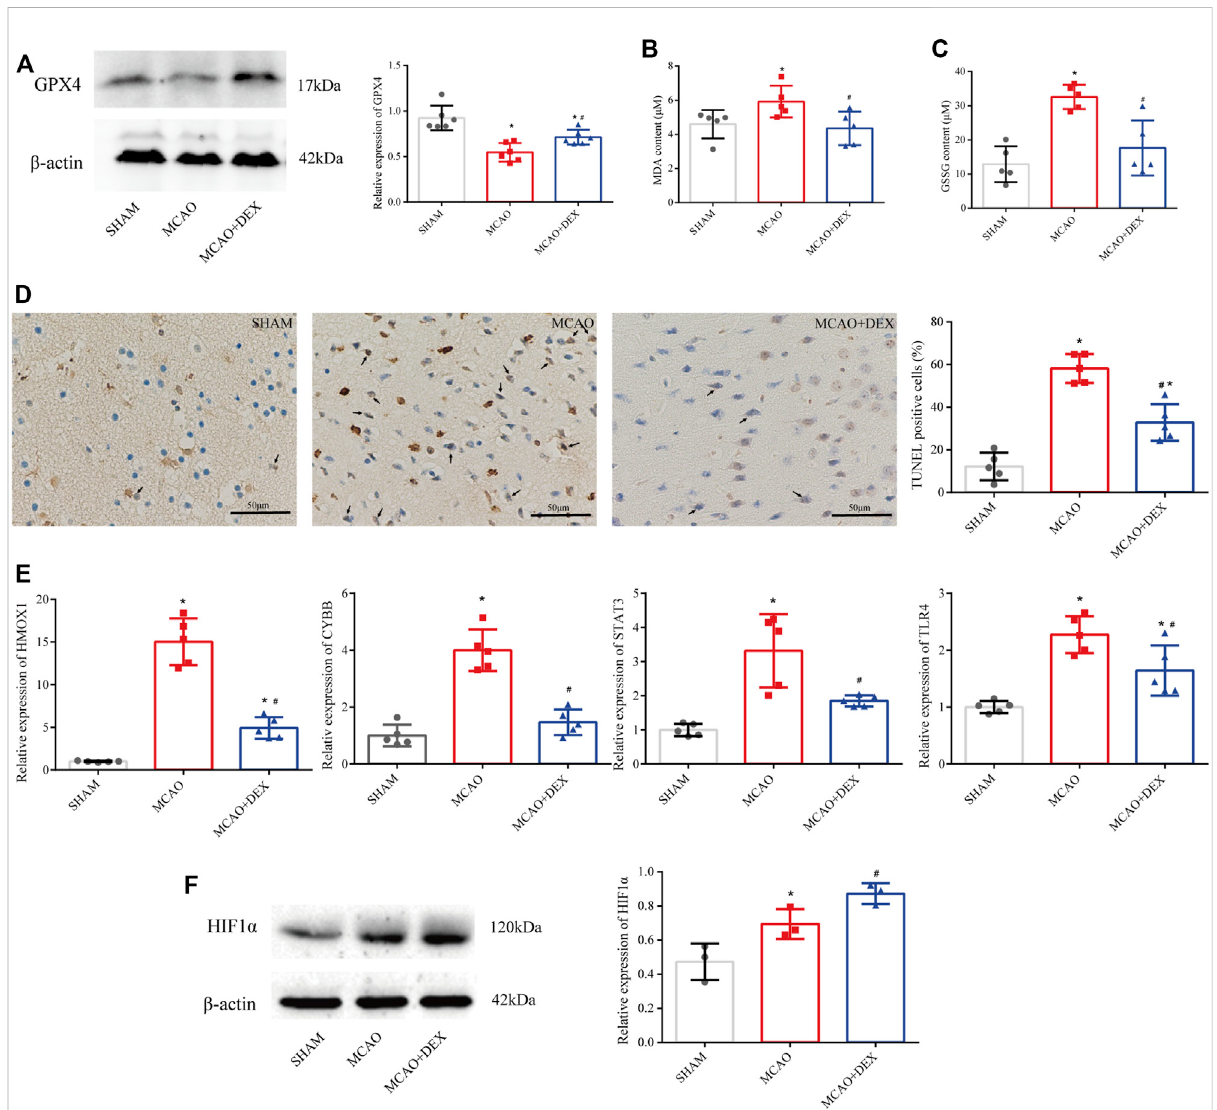
FIGURE 8 (A) Western blotting analysis ofGPX4 inthepenumbraarea ( n = 6per group). (B) MDA levels in brain tissues ( n = 5per group). (C) GSSG levels in brain tissues ( n = 6 per group). (D) TUNEL staining in SHAM, MCAO and DEX + MCAO mice (Scale bars = 50 μ m) and quanti fi cation of the number of TUNEL+ cells ( n = 3). (E) Relative mRNA levels of HMOX1, CYBB, STAT3, and TLR4 in mice brain by qRT-PCR ( n = 5). (F) Western blotting analysis of HIF1 α in the penumbra area ( n = 3). Data are presented as the mean ± SD. *p < 0.05 vs. SHAM group, #p < 0.05 vs. MCAO